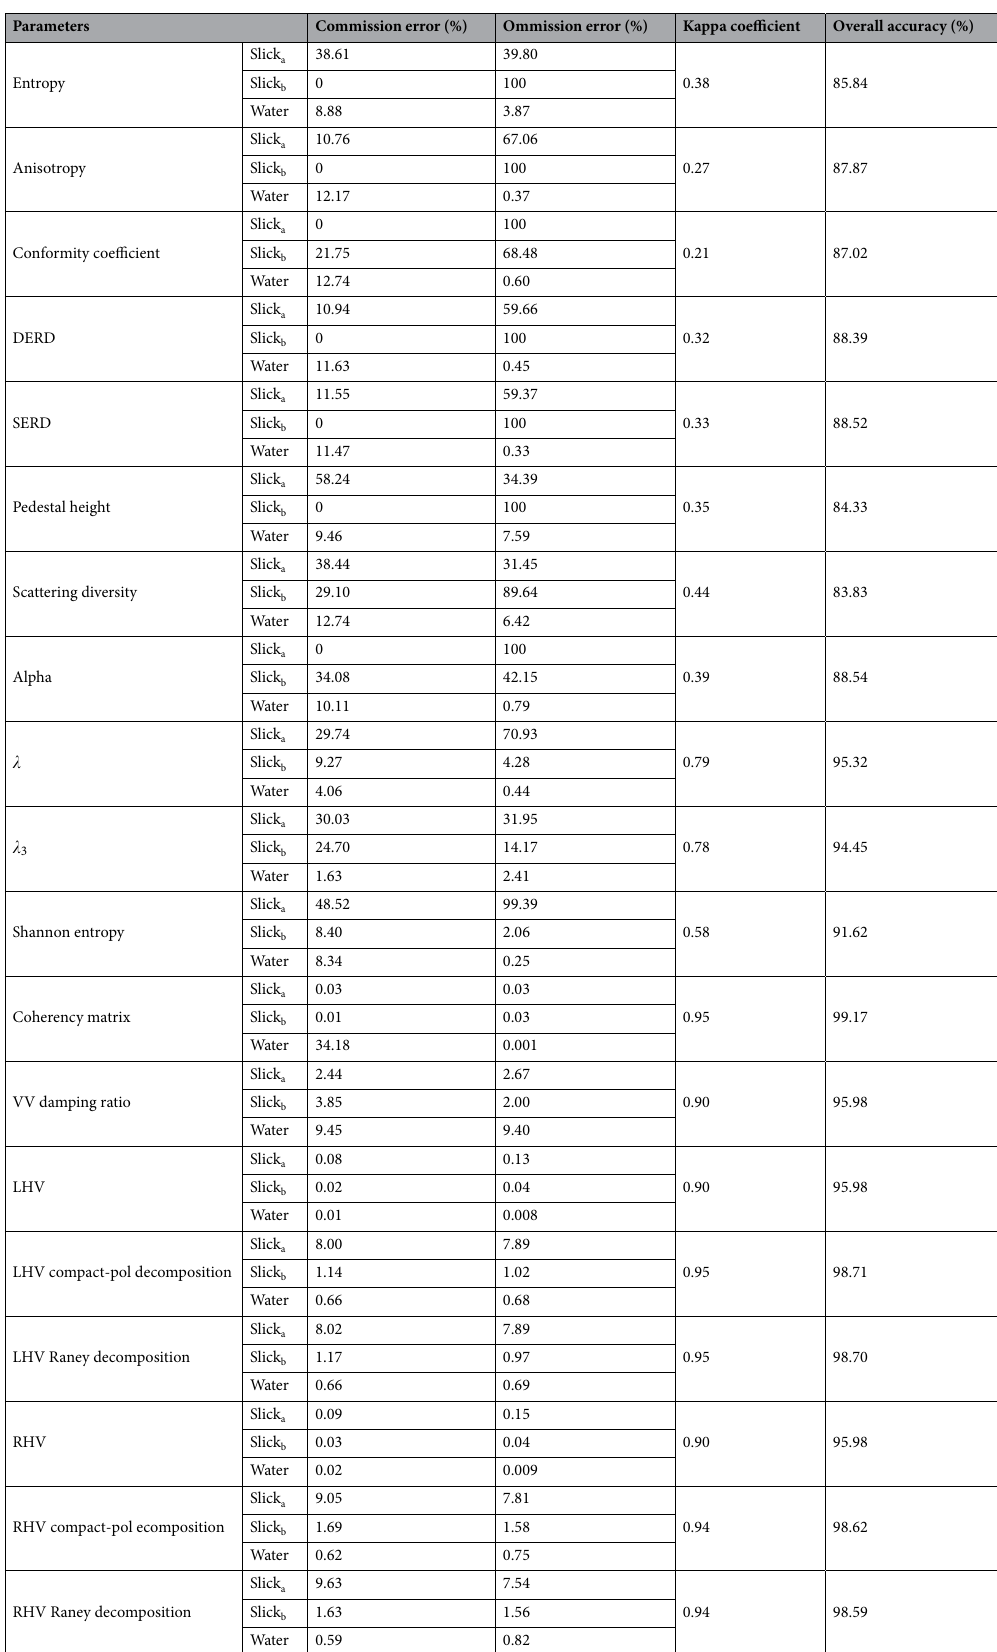
Table 5. Achieved accuracy with all tested parameter for each class using SVM